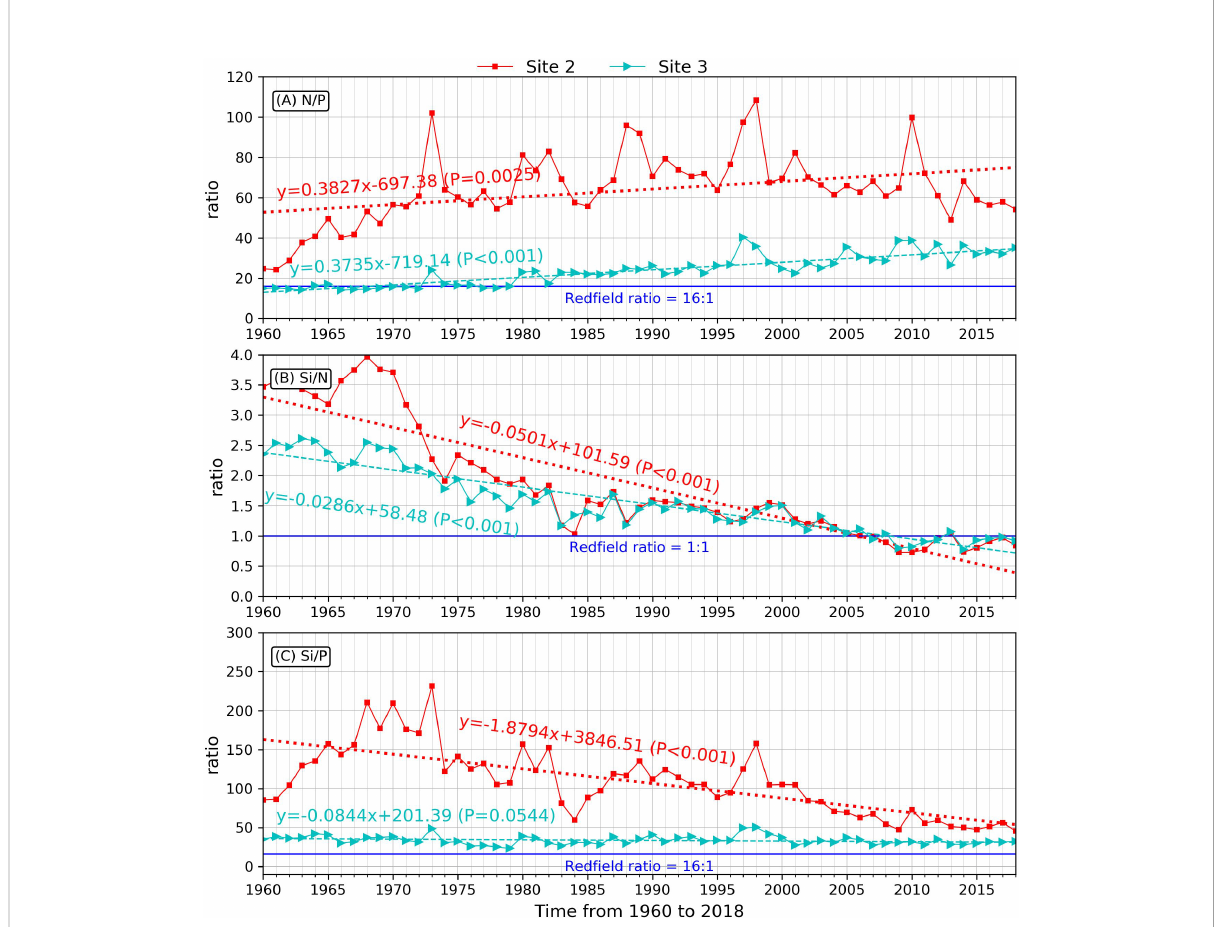
FIGURE 6 Nutrient ratios of N/P (A) , Si/N (B) , Si/P (C) at site 2 (red) and site 3 (green). The dashed lines are the regression fi tting of the nutrient ratios. Blue lines indicate threshold of the Red fi eld ratio.